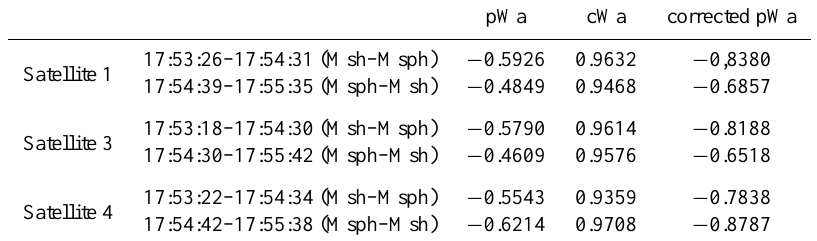
Table 2. Wal´en test results for the two consecutive magnetopause crossings discussed in detail in this section. p Wa represents the fitting slope of ( V – V HT ) versus V A and c Wa the corresponding correlation coefficient. The last column indicates the value of p Wa after correction of the density. These results don’t take into account the density correction due to the inadequate operating mode of the CIS experiment.